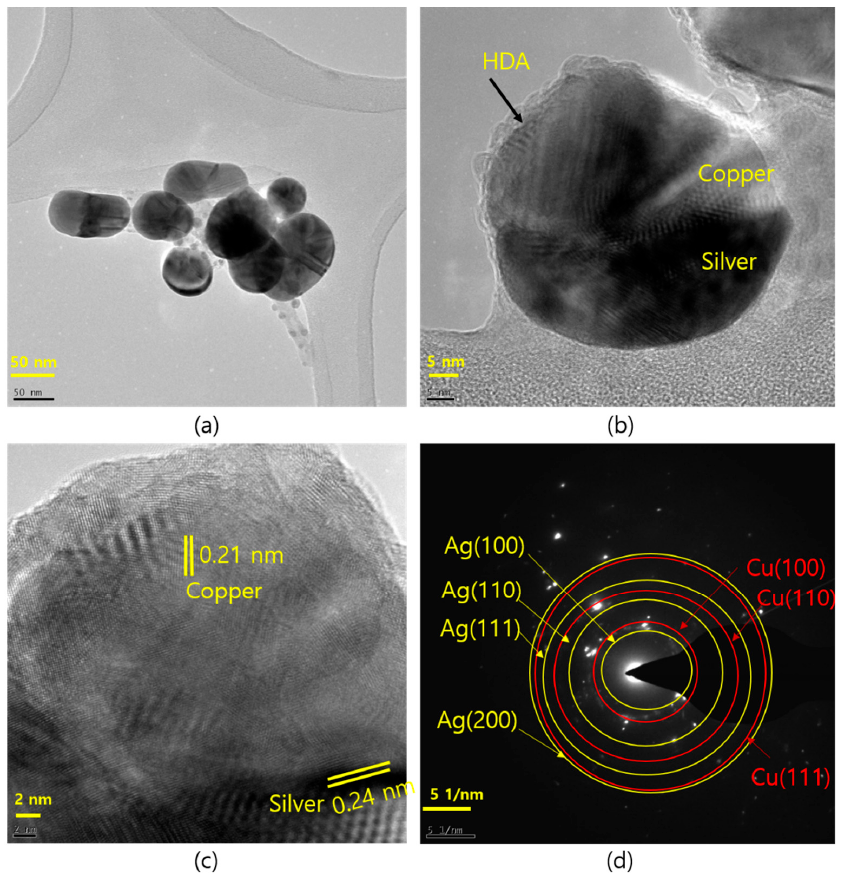
Figure 3. Different magnification HR-TEM images of copper-silver bimetallic nanostructures: ( a ) 100 nm; ( b ) representing the silver and copper nanoparticles with hexadecylamine (had) layer; ( c ) lattice fringes of Cu-Ag nanoparticle; and, ( d ) SAED pattern of Cu-Ag nanoparticles. To confirm the composition and distribution of NPs, EDX analysis is applied to the spectra and elemental mapping. Figure 4 shows STEM-HAADF image, elemental mapping, and EDX spectrum images of copper-silver bimetallic nanostructures. Studies on size, shape, and morphology of the Cu-